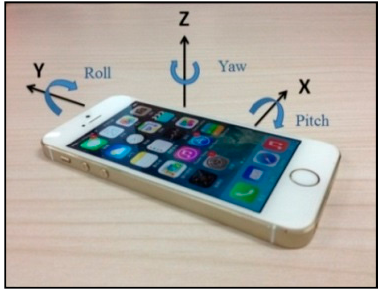
Figure 4. Angle-of-rotation directions.